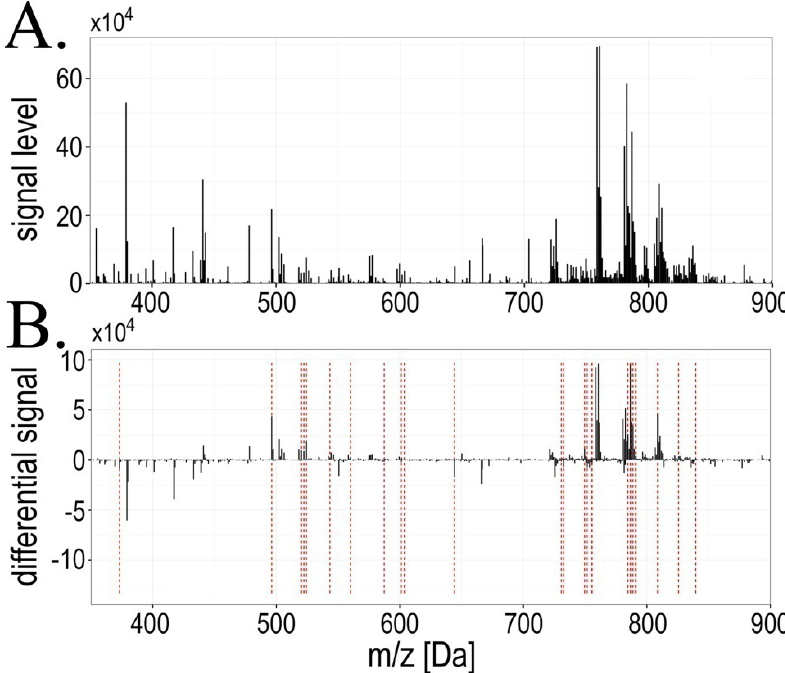
Figure 1. Mass profiles of serum lipids were affected during radiotherapy. (Panel A ): Averaged mass spectrum of serum lipids registered in the 350–900 Da range for pre-treatment samples ( A ); (Panel B ): Averaged differential spectrum for pre-treatment and within-treatment samples (A ∆ B); components that changed their abundances significantly (FDR < 5%) are marked with red